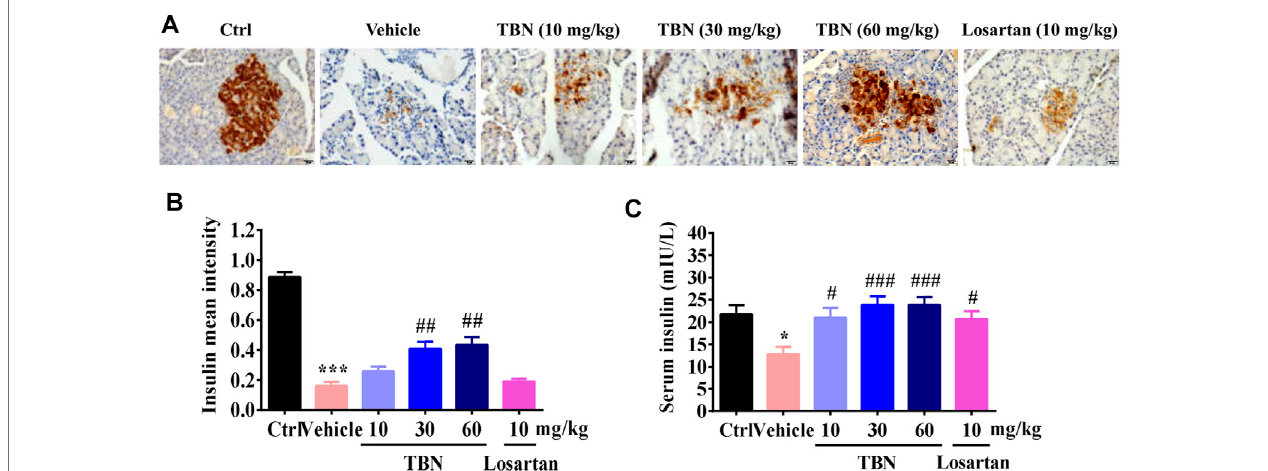
FIGURE4| TBNprotectsisletbetacellsandincreasesinsulinsecretioninSTZ-inducedrats. (A) Representativephotomicrographsofinsulinimmunostaininginthe pancreasesofdifferentgroups.Scalebars,20 µm. (B) Semi-quantitativeanalysisofinsulinimmunostaininginthepancreas.Brownstainingindicatestheimmunopositive area for the protein of interest. 30 images of immunostaining sections were counted for each rat. n (cid:1) 13 for vehicle-treated DM group and n (cid:1) 16 for other groups. (C) Serum concentrations of insulin in STZ-induced DKD rats. Data were expressed as means ± SEM. Signi fi cance was determined by one-way ANOVA followed